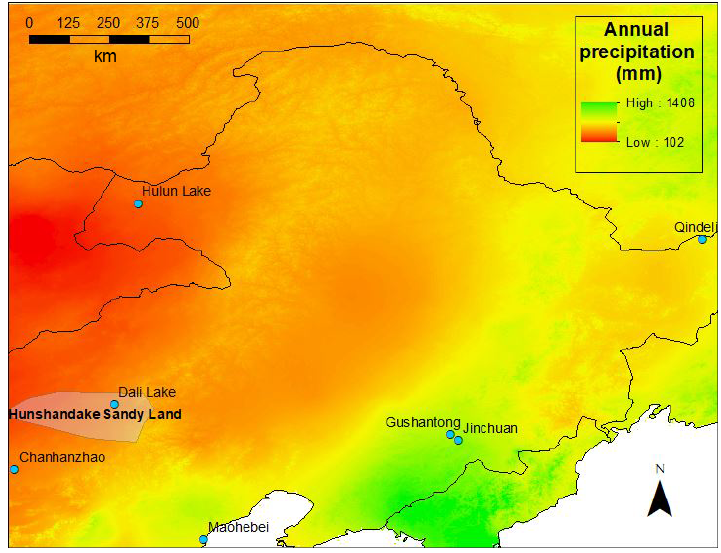
Figure 7. Modeled annual precipitation (mm) for 6.0kaBP (Hijmans et al. 2005) from the Beijing Climate Center Climate System Model (Version 1.1). Seven sites derived from An et al. (2000) are shown (green dots) to illustrate the incomplete spatial distribution of records within individual research records across the